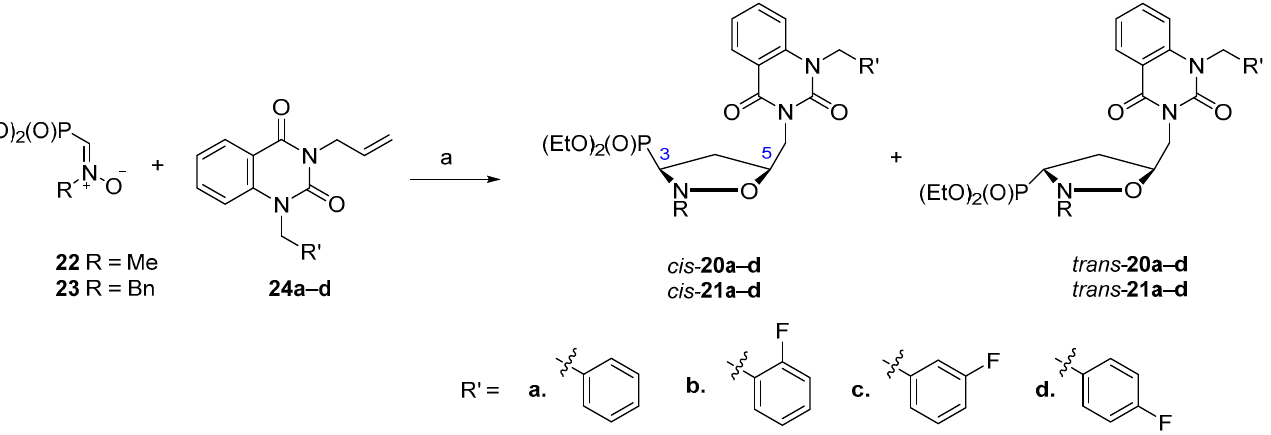
Scheme 3. Synthesis of isoxazolidines 20 and 21 . Reaction and conditions: (a) toluene, 60 ◦ C, 72 Table 1. Cycloadditions of the nitrone 22 / 23 and N 3 -allyl- N 1 -benzylquinazoline-2,4-diones 24a–d .